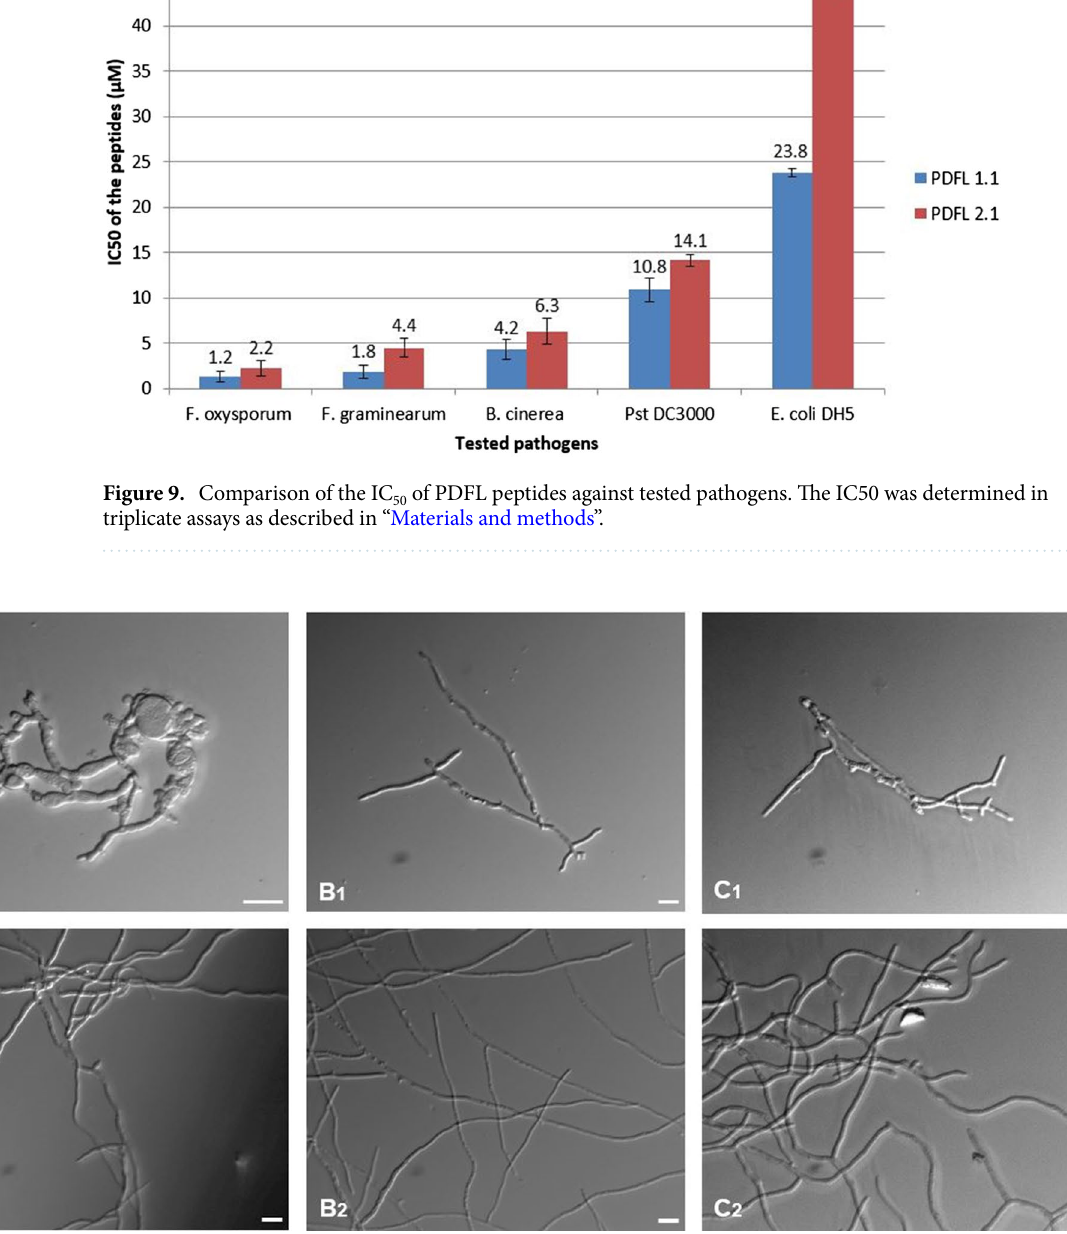
Figure 10. Effect of PDFL2.1 (100 µg/ml) on fungi. ( A ) A1: Hyperbranching and swelling of Fusarium graminearum hyphae, A2: Untreated hyphae of F. graminearum . ( B ): ( B1 ) Inhibition of the hyphal growth of F. oxysporum f.sp. matthiolae without inducing hyperbranching, ( B2 ) Untreated hyphae of F. oxysporum f.sp. matthiolae . ( C ): ( C1 ) Inhibition of the hyphal growth of Botrytis cinerea without inducing hyperbranching, ( C2 ) untreated hyphae of B. cinerea . Scale bar = 20